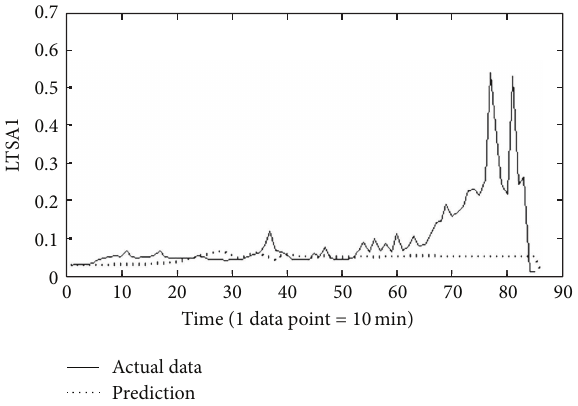
Figure15:TheactualdataandtheresultpredictedbyBPNNfallinto the local optimum.